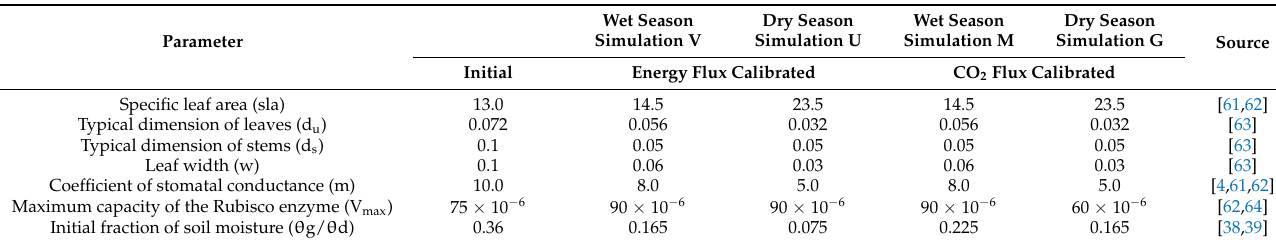
Table 2. Calibrated parameters: Specific leaf area (sla, m 2 leaf kg − 1 C), typical dimension of leaves (d u , m), typical dimension of stems (d s , m), leaf width (w, m), coefficient of stomatal conductance (m, dimensionless), maximum capacity of the Rubisco enzyme (V max , µ mol CO 2 m − 2 s − 1 ), and initial fraction of soil moisture ( θ g/ θ d, dimensionless). Where θ g is the soil water content based on mass expressed in the gravimetric soil moisture content, θ d is the soil moisture. Uppercase letters (V, U, M and G) represent the best calibrated simulations in the wet season and dry season of 2014, analyzed by means of Taylor